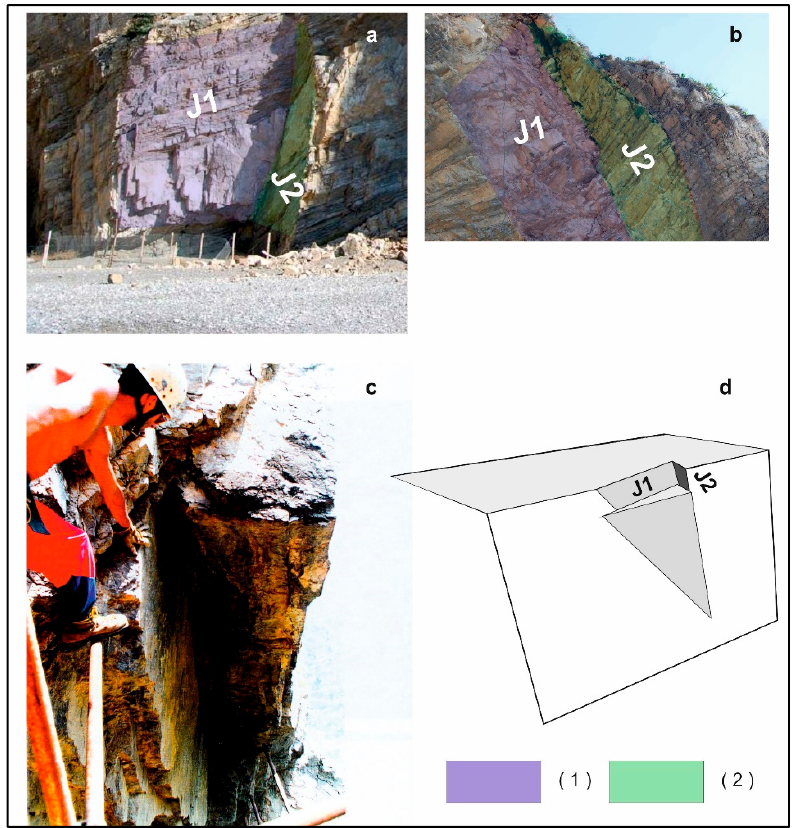
Figure 8. View of the slope potentially prone to wedge failures. ( a , b ) wedges already failed along joints belonging to the J1 (violet) and J2 (green) joint sets; ( c ) morphology caused by an already failed wedge whose line of intersection is nearly vertical; ( d ) 3D perspective view of the model adopted in calculations. Key: (1) joint surface belonging to the J1 joint set; (2) joint surface belonging to the J2 joint set.